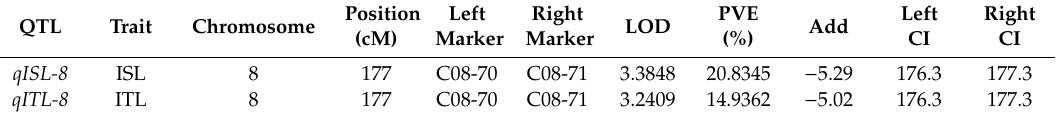
di ff erences between homozygous alleles of ‘Nong-an’ and ‘Sathi’ (Figure